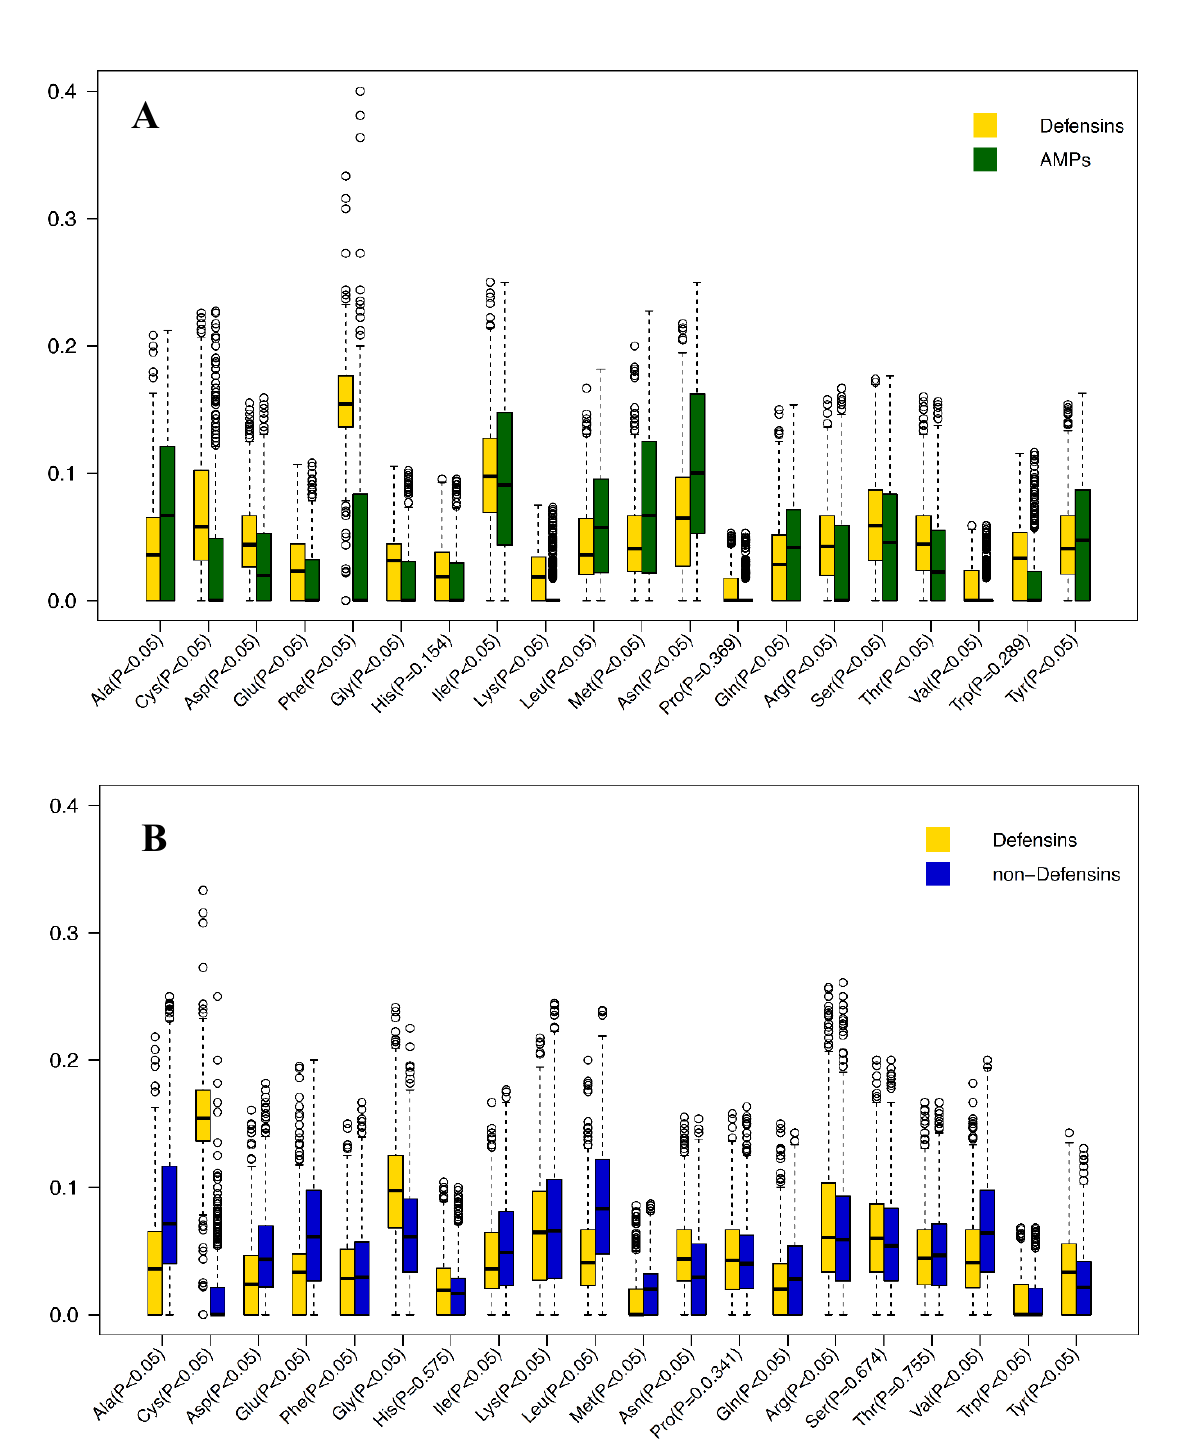
Figure 2: Boxplots of average amino acid compositions of 20 amino acids of Defensins vs AMPs (A) and Defensins vs non-Defensins (B). X- and Y-axes represent 20 amino acids along with their p -value and average amino acid